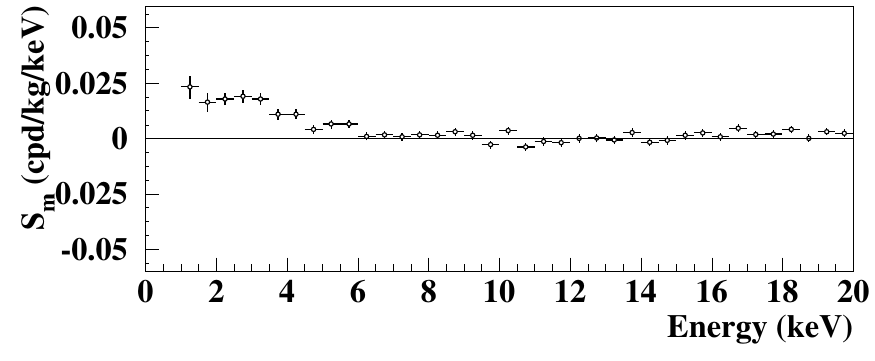
Figure 4. Modulation amplitudes, S m , for the whole data sets: DAMA/NaI, DAMA/LIBRA–phase1 and DAMA/LIBRA–phase2 (total exposure 2.46 ton × year) above 2 keV; below 2 keV only the DAMA/LIBRA-phase2 exposure (1.13 ton × year) is available and used. The energy bin ∆ E is 0.5 keV. A modulation is evident in the lowest energy interval, and only S m ’s compatible with zero are present just above. In particular, the S m have random fluctuations around zero in (6–20) keV energy region with χ 2 equal to 42.6 for 28 d . o . f . (upper tail probability of 4%); see text for comments. For the case of (6–20) keV, energy interval χ 2 / d . o . f . = 42.6/28 (upper tail probability of 4%).